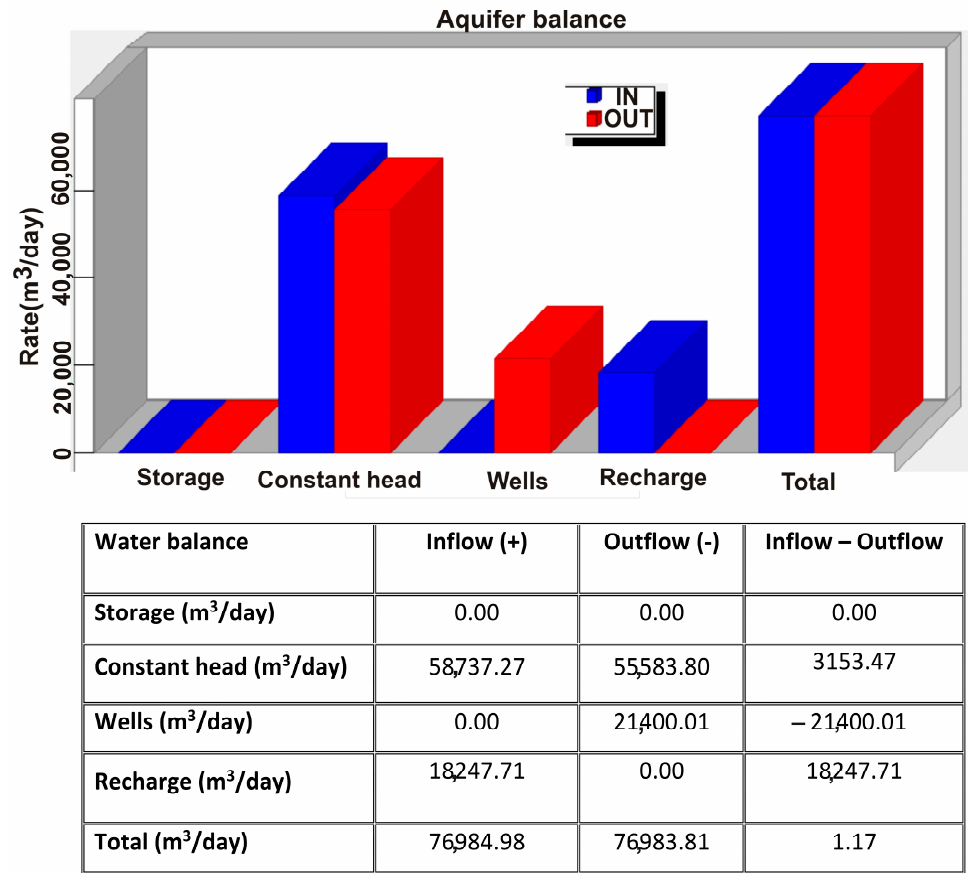
Figure 11. Water balance components of the calibrated model.